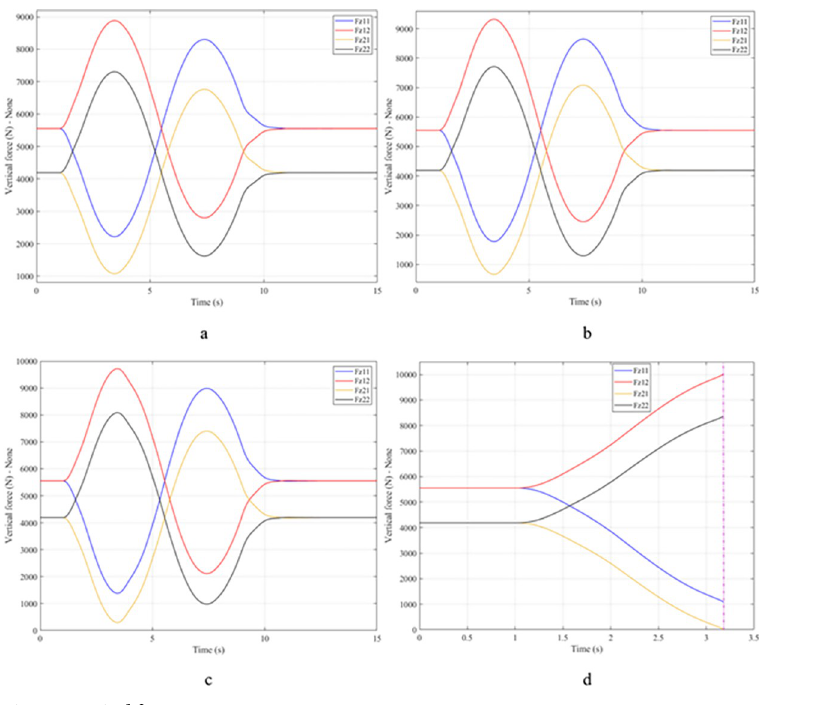
Fig 13. Vertical